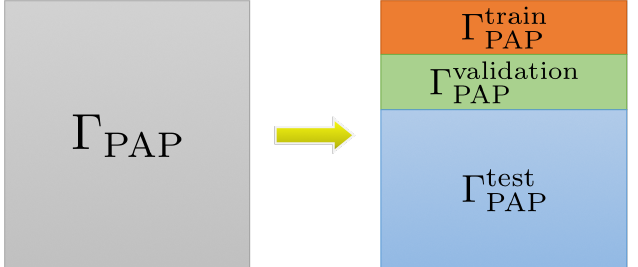
Figure 2. Dataset structure. The datasets were randomly subdivided into train, validation, and test